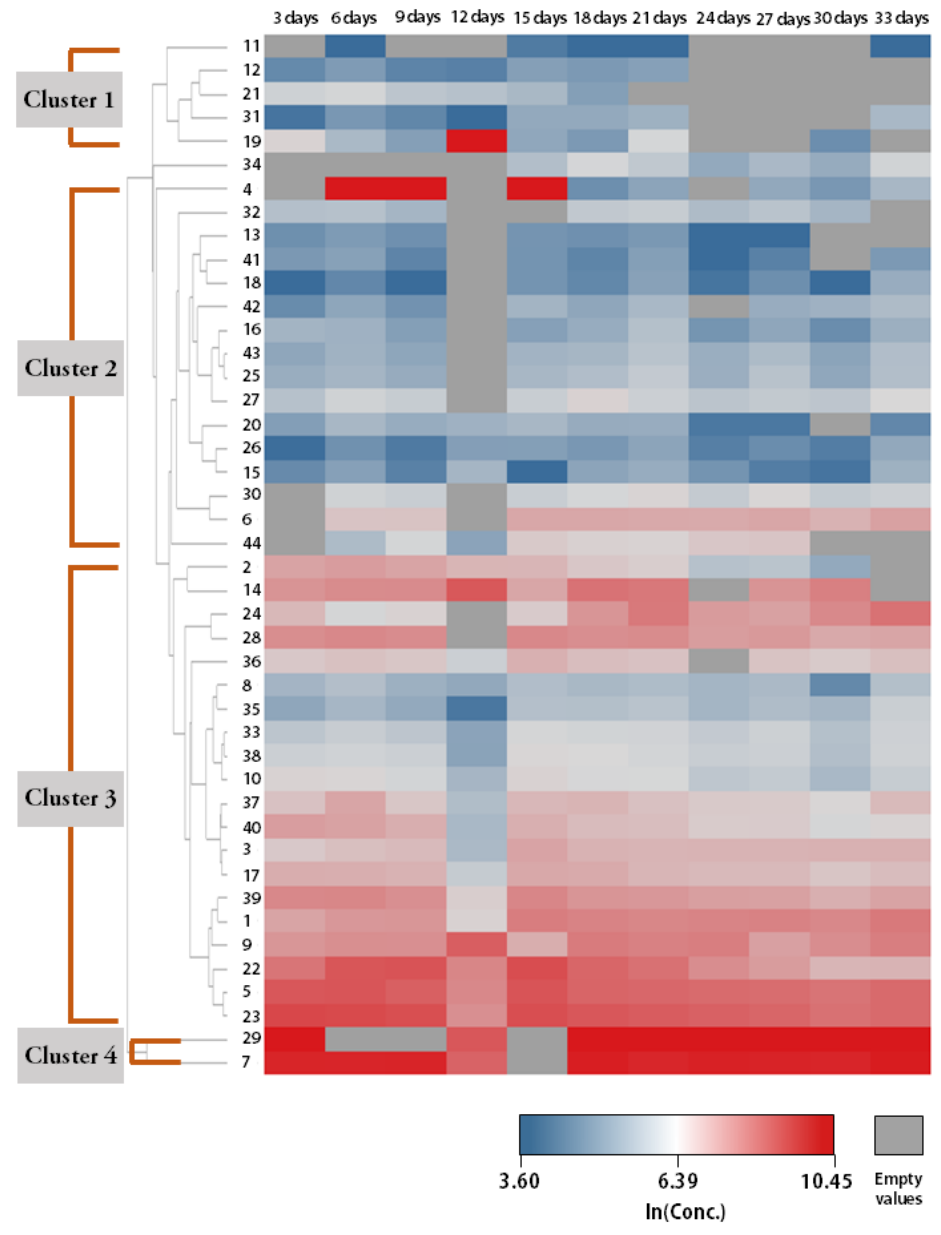
Figure 3. Temporal emission patterns of mVOCs originating from Aspergillus niger grown on silicone rubber during the cultivation period. Depending on the temporal emission patterns, compounds were classified into four clusters. Compounds were symbolized with numbers on the y -axis (see Table S6 for detailed